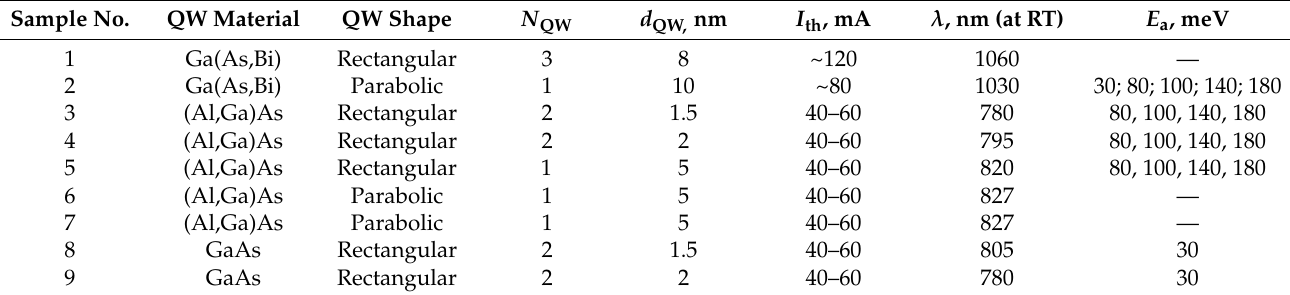
Figure 1. The schematic picture of the laser diode structure ( a ) and various designs of the active area containing parabolic and rectangular single or multiple QWs of (Al, Ga)As and Ga(As, Bi) ( b , c ). Table 1. The main parameters of the investigated laser diodes: QW material—quantum well composition; QW shape—QW profile; N QW —number of QWs; d QW , nm—QW thickness; I th , mA—threshold current; λ , nm (at RT)—lasing wavelength at room temperature; E a , meV—activation energy of the trapping centers.